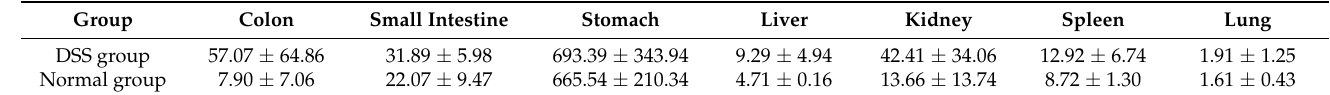
Table 5. Tissue–plasma partition coefficients (Kp) of M10 after oral administration of M10 at a dose of 50 mg/kg in the normal and DSS groups (mean ± SD, n =